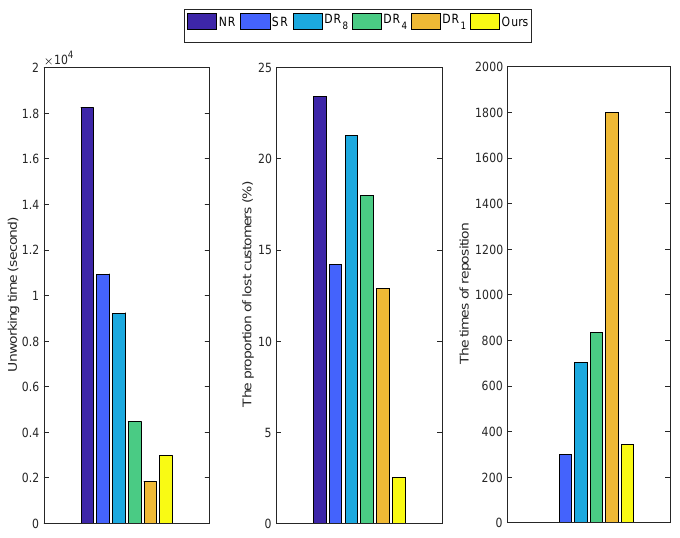
Figure 9. Comparison of system performance.